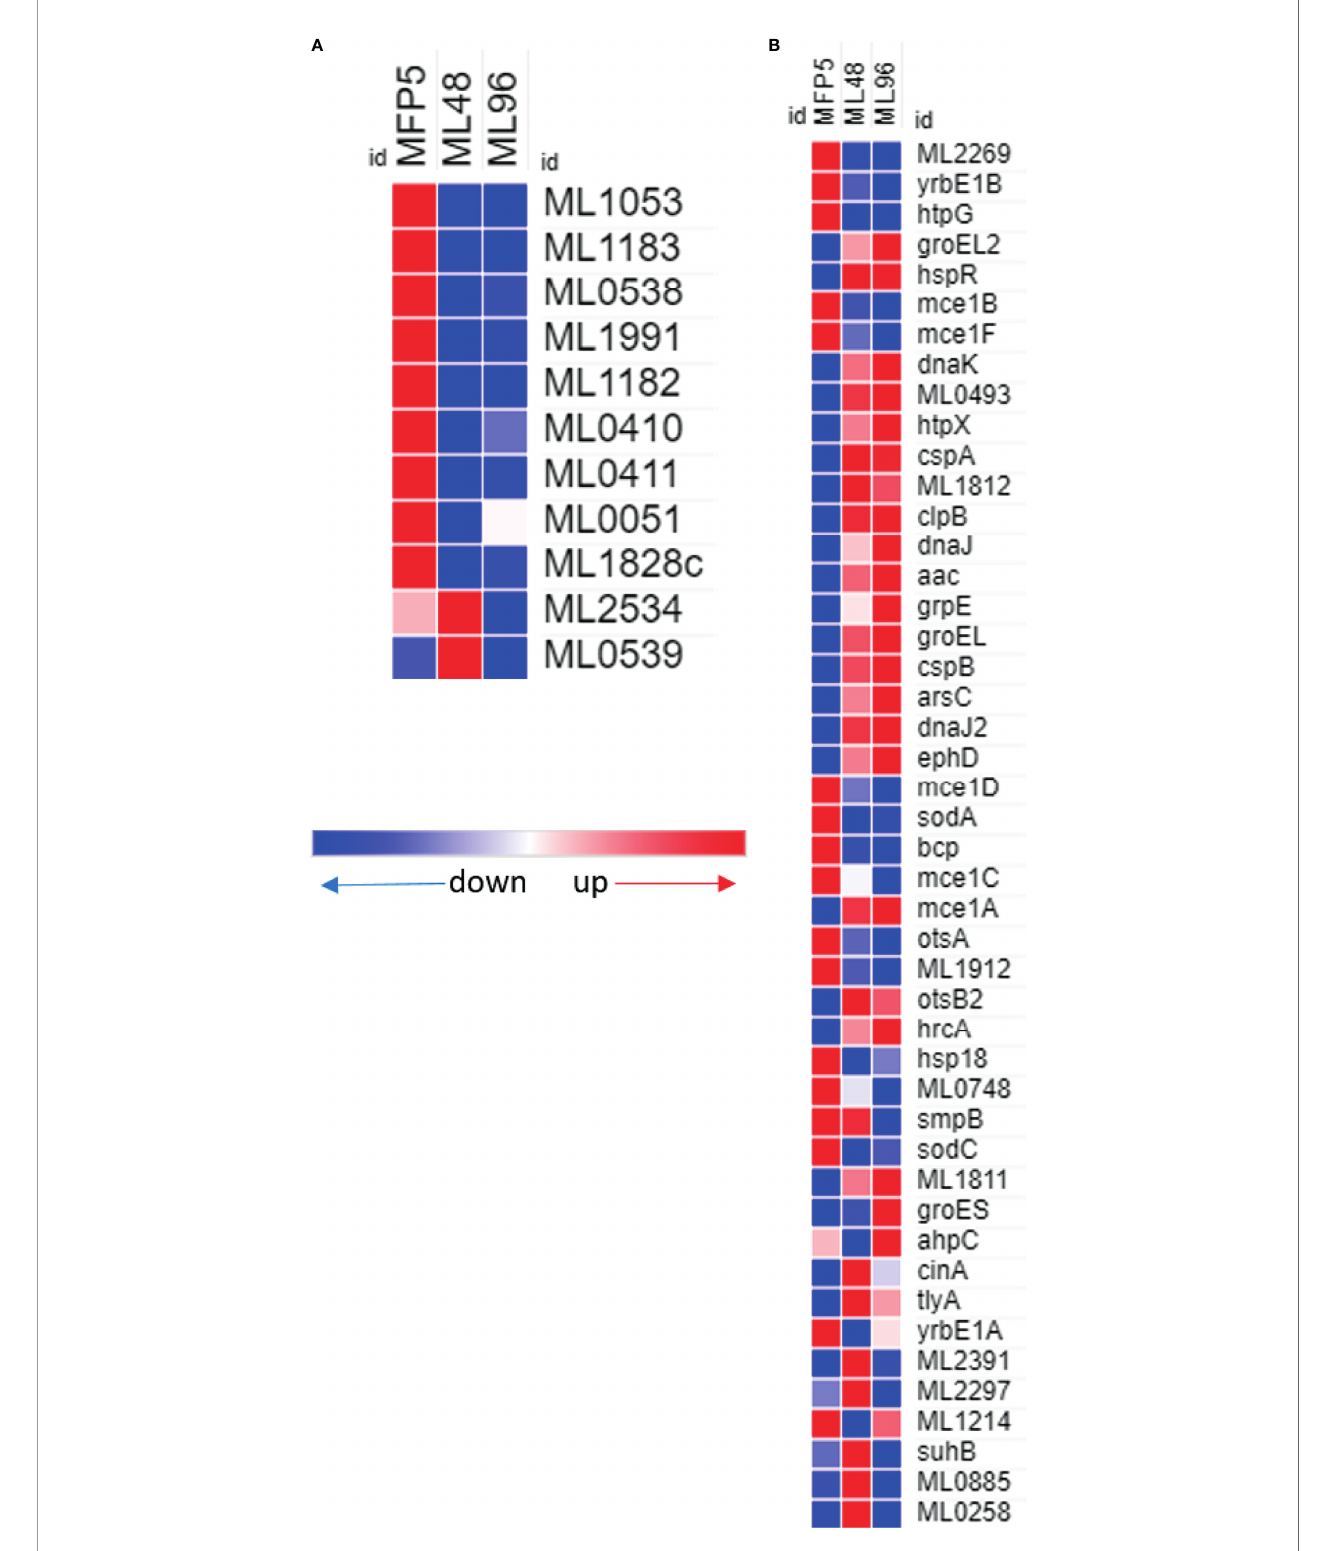
FIGURE 7 | Differential expression (average abundance) of M. leprae genes under in vivo (MFP5) and in vitro (ML48 & ML96) conditions. (A) PE/PPE proteins, (B) proteins associated with